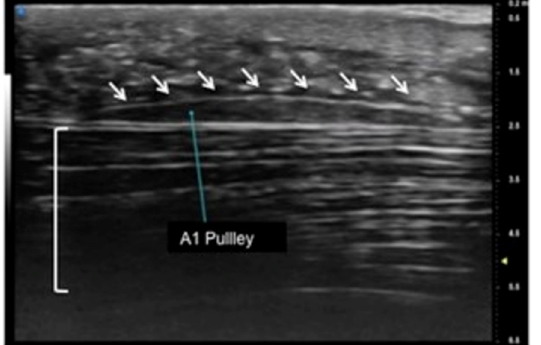
Figure 1. Sagittal view of A1 pulley (white arrows) presenting as a fusiform structure with a hypo-echoic signal contoured by a thin hyperechoic line. The superficial flexor tendon is visible (square parenthesis).